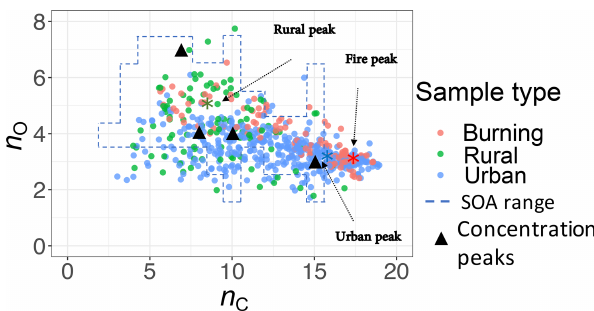
Figure 13. Comparison between the carbon–oxygen grid simulated by Jathar et al. (2015) for Atlanta and Los Angeles with sample points estimated for the IMPROVE network (2011 and 2013) from the molecular weight and carbon number estimates of this study. The dashed lines show the range of simulated carbon and oxygen, and the triangles indicate the location of the highest SOA concen- trations for the simulations of Jathar et al.